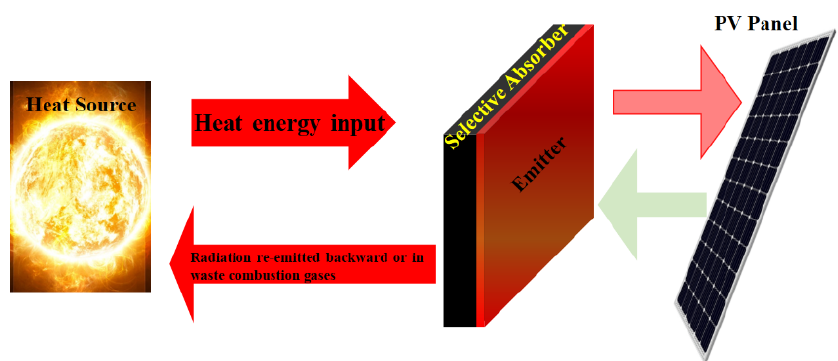
Figure 16. Illustration of a conversion system for TPV energy. The thermal radiation of the sun heats an intermediate absorber. Filter-transmitted radiation from the emitter illuminate the photovoltaic (PV) cell.